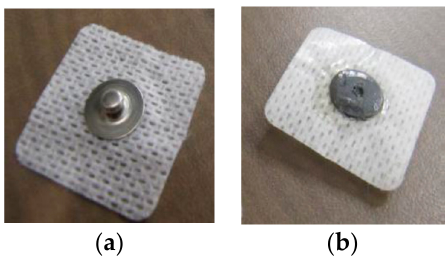
Figure 2. ( a ) Ag/AgCl electrode (electrode’s snap side); ( b ) Ag/AgCl electrode (electrode’s skin side).